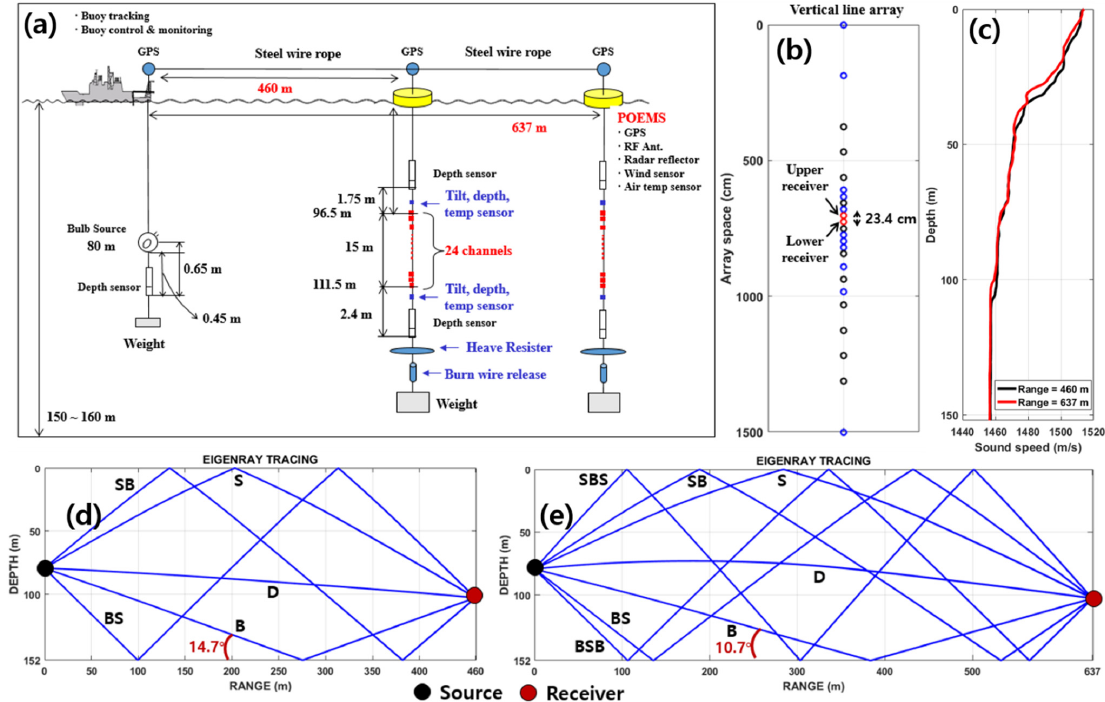
Figure 5. ( a ) Experimental geometry. ( b ) Layout of POEMS showing the spacing between 24 hydrophones. Two hydrophones in the middle of the POEMS and 23.4 cm apart were selected, of which the midpoint was 103.7 m-deep. ( c ) Sound speed profiles measured by XBT at 0218 and 0342 UTC. Eigenray outputs for source–receiver ranges of ( d ) 460 m and ( e ) 637 m based on the sound speed profiles. Grazing angles of B paths are 14.7° and 10.7 ° for 460-m and 637-m ranges, respectively; they are smaller than the estimated critical angle (26.8 ° ) and therefore produce strong B paths.